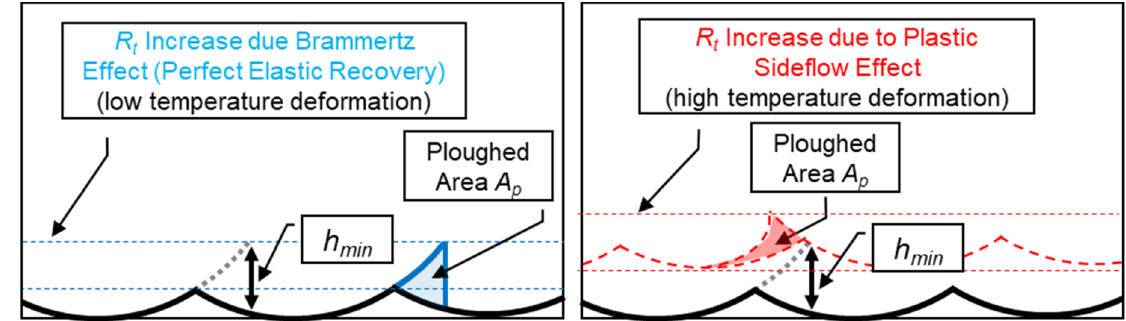
Figure 2. Schematic illustration of the difference between elastic material response (left/blue) and plastic sideflow (right/red), the latter of which is proposed to represent typical thermoplastic material response during machining.